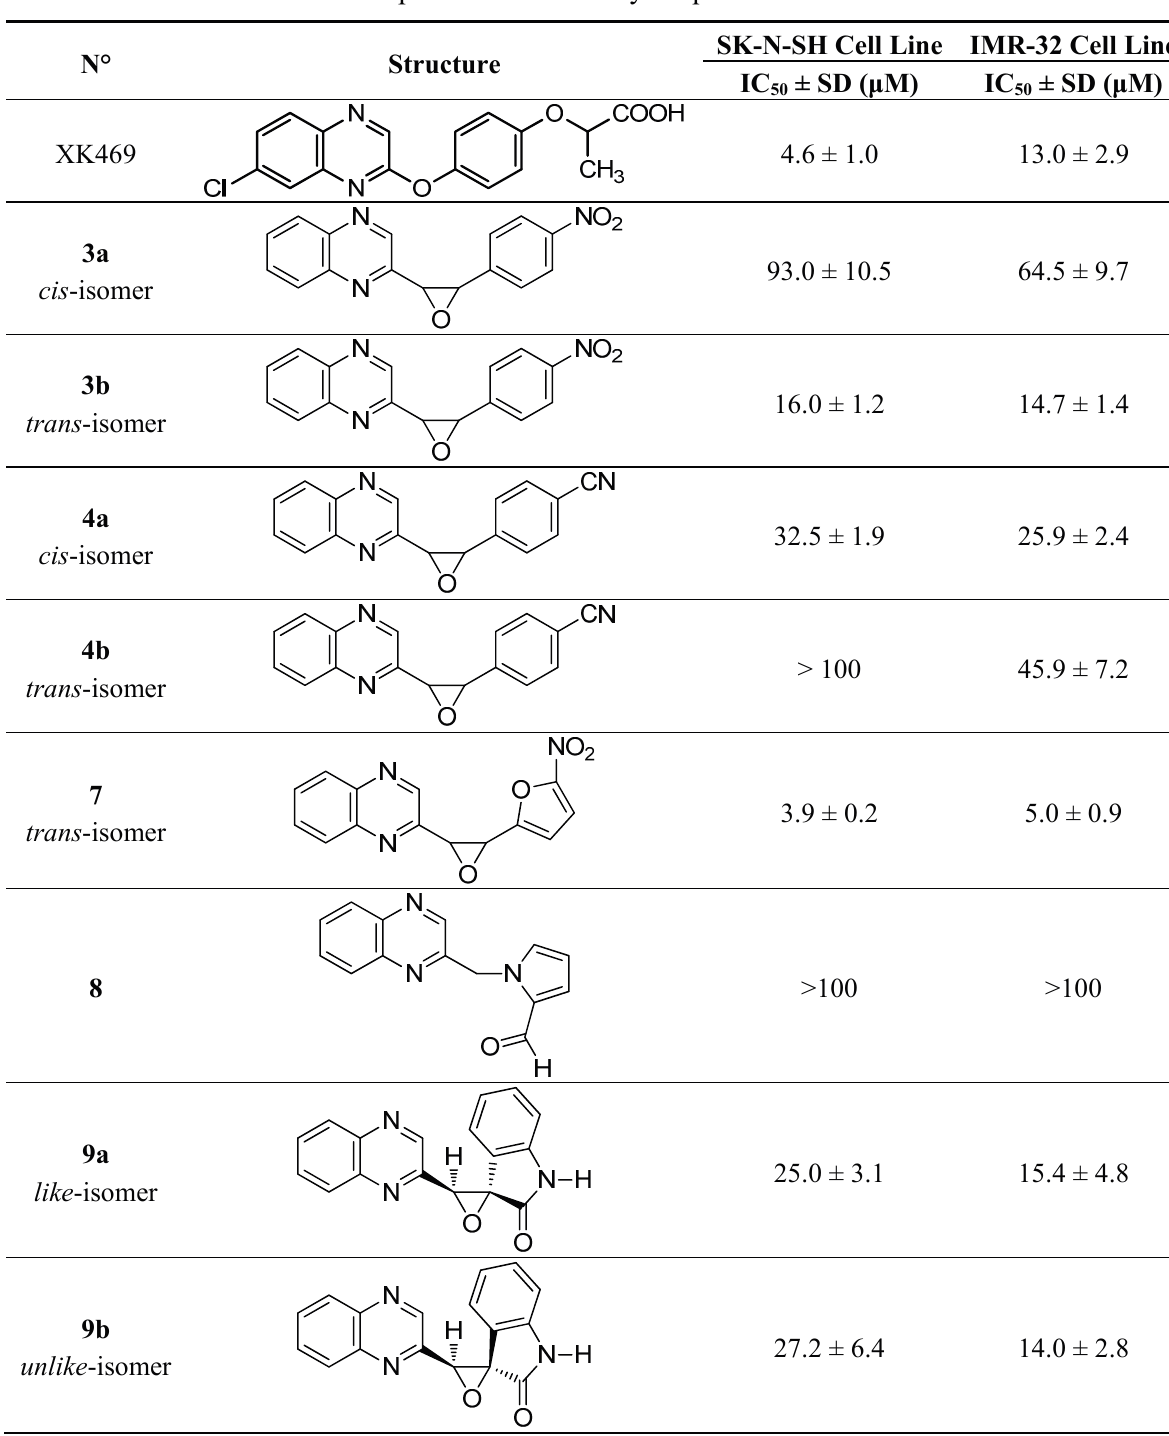
Table 1. Anti-proliferative activity of quinoxaline